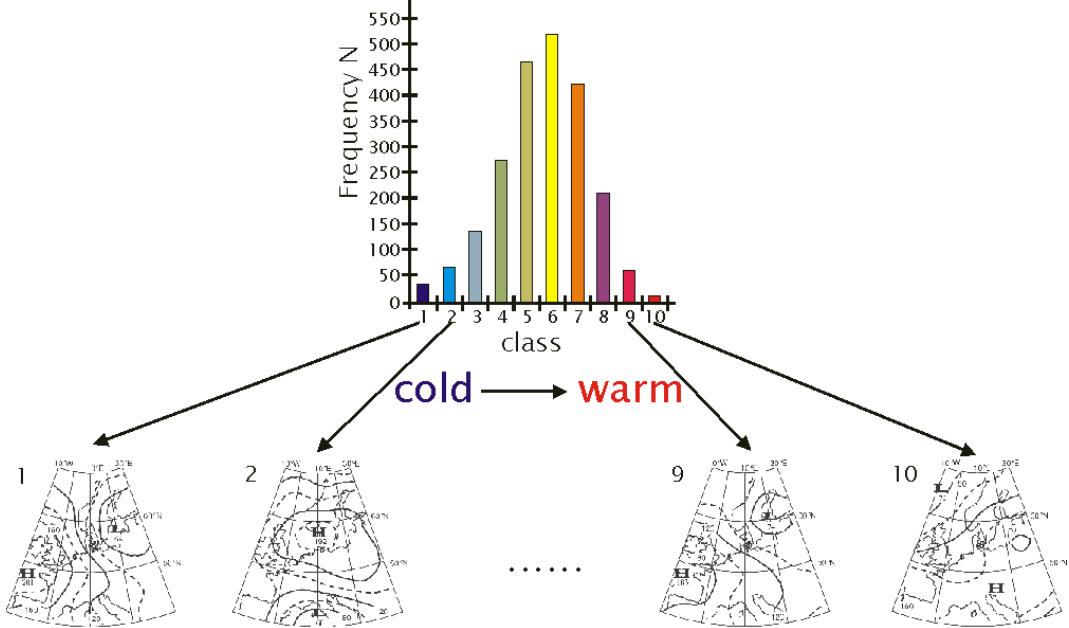
Figure 2. Sketch of the initialization of circulation pattern classes, building a frequency distribution of days belonging to different ranges of regionally aggregated temperature (upper part) and the formation of composita for each temperature range class (lower part), as carried out in